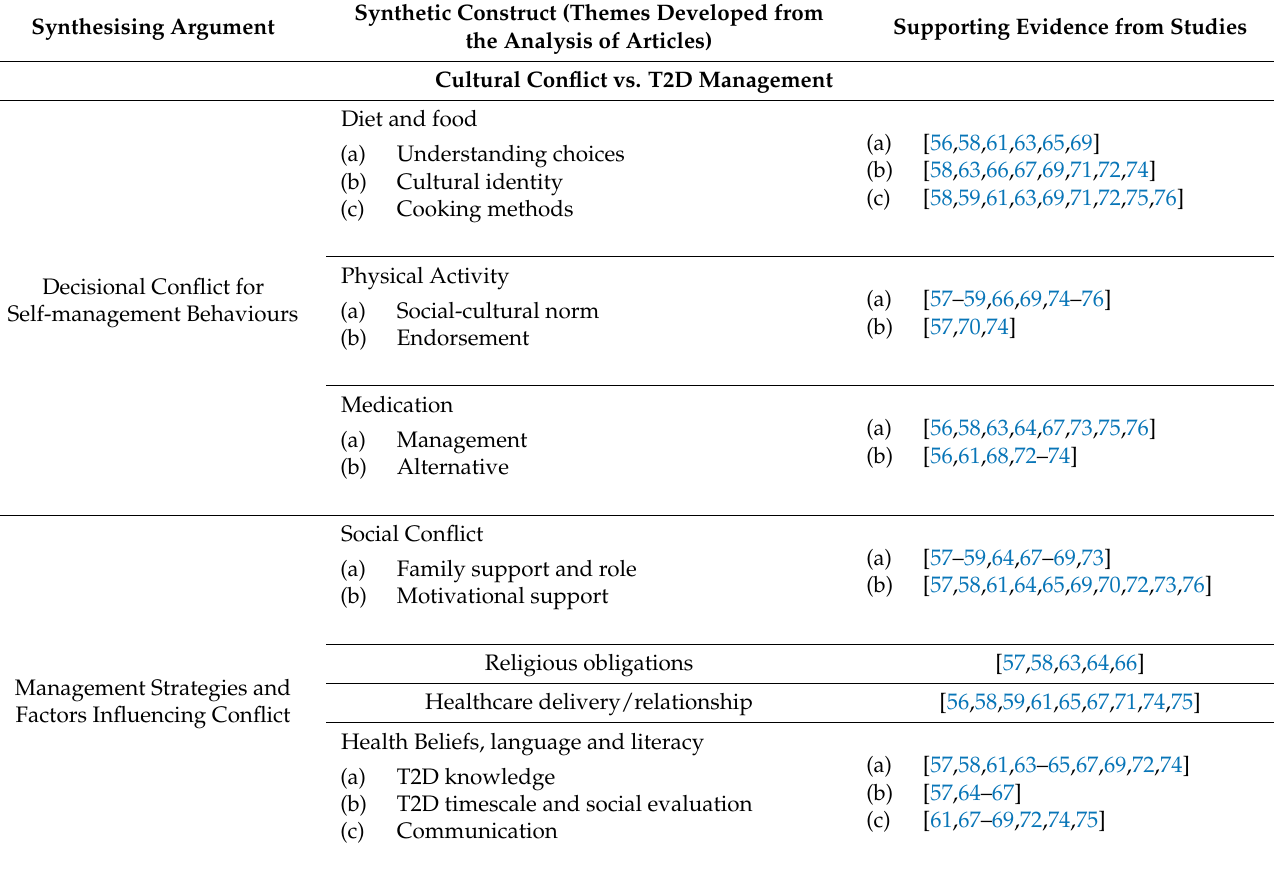
Table 2. Synthesising argument, synthetic constructs and summary of supporting evidence. Synthetic Construct (Themes Developed from Supporting Evidence from Studies Synthesising Argument the Analysis of Articles) Cultural Conflict vs. T2D